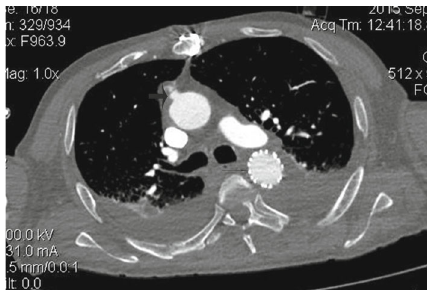
Figure 2: The fi rst arrow indicates a graft anastomosed to the ascending aorta. The second (thin) arrow indicates endograft in the distal arch and the descending thoracic